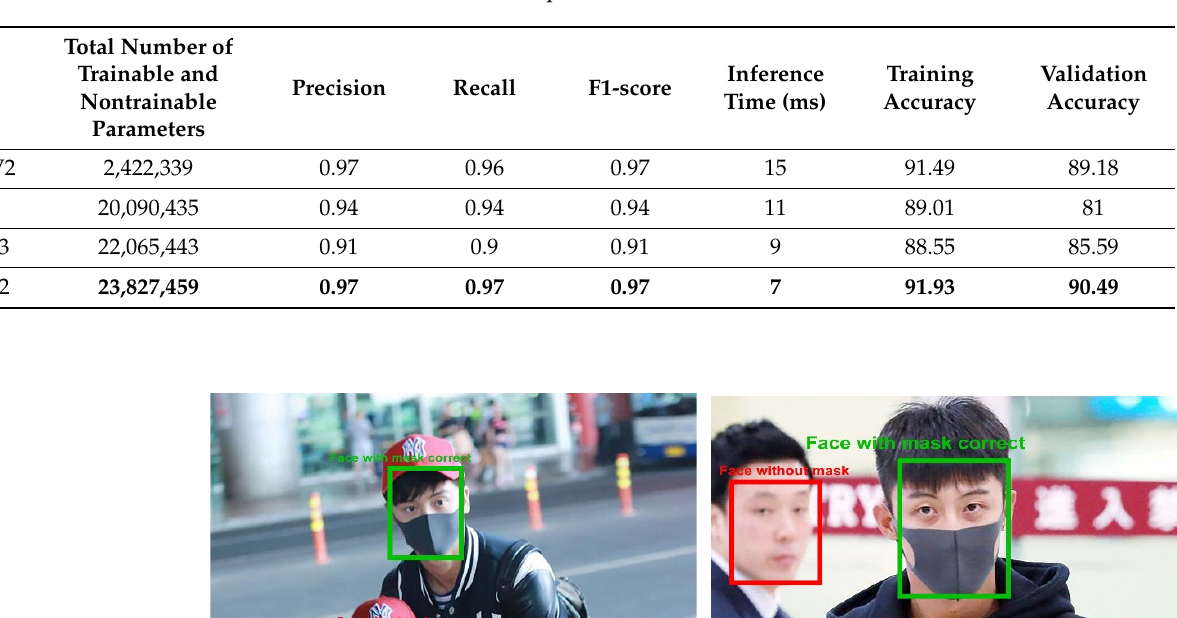
Table 3. Different models and their parameter values.